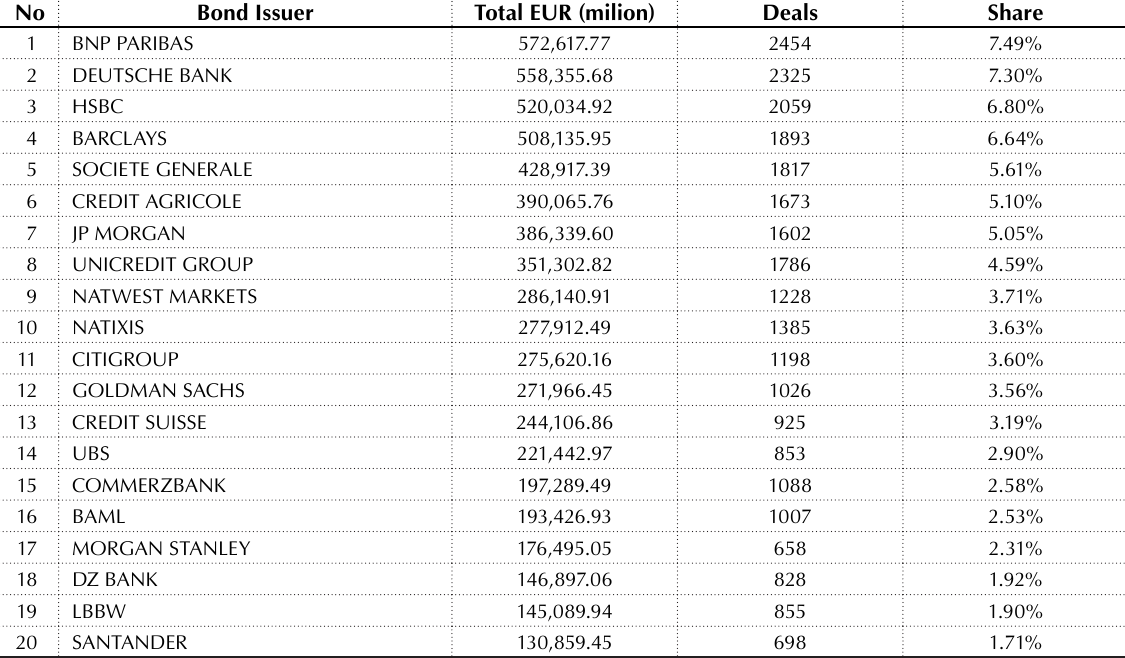
Table 1. TOP 20 leading investment